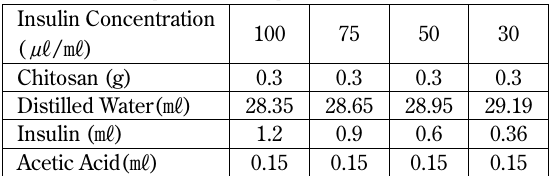
Table 1 The Composition of Nanoparticles